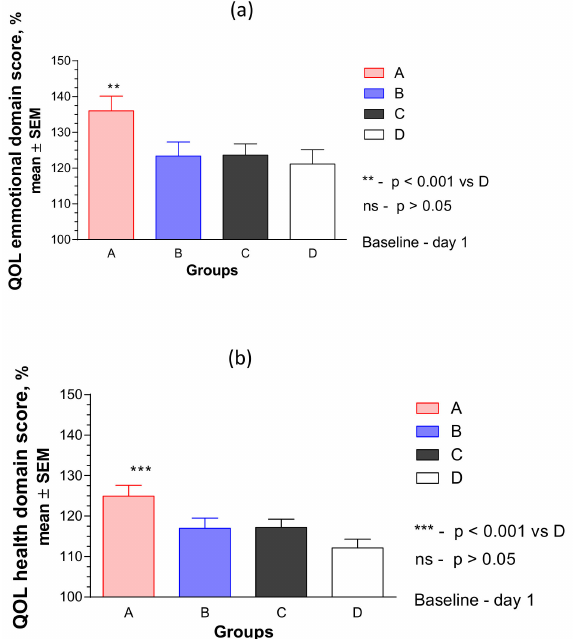
Figure 5. E ff ects of RR-BC (Group A), BC (Group B), BC500 (Group C), and placebo (Group D) on ( a ) emotional and ( b ) physical health domains of quality of life after 12 weeks of treatment, as assessed by the UQOL scale. A significant di ff erence in UQOL (% to baseline, 100%, mean ± SEM) was observed in group A compared to placebo group at the end of the treatment—Day 84, ( p < 0.0001), but not between groups B or C vs. placebo; ns: not